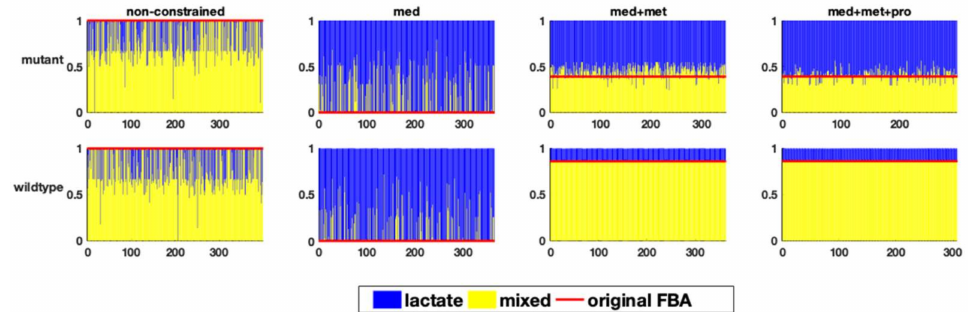
Figure 4. The relative flux distribution in the branching point of carbohydrate fermentation (y-axis) in response to one perturbation in each of the variable reactions (x-axis) in the two studied genome-scale models of E. faecalis , resulting in homolactic or mixed acid fermentation in the two genome-scale models of E. faecalis